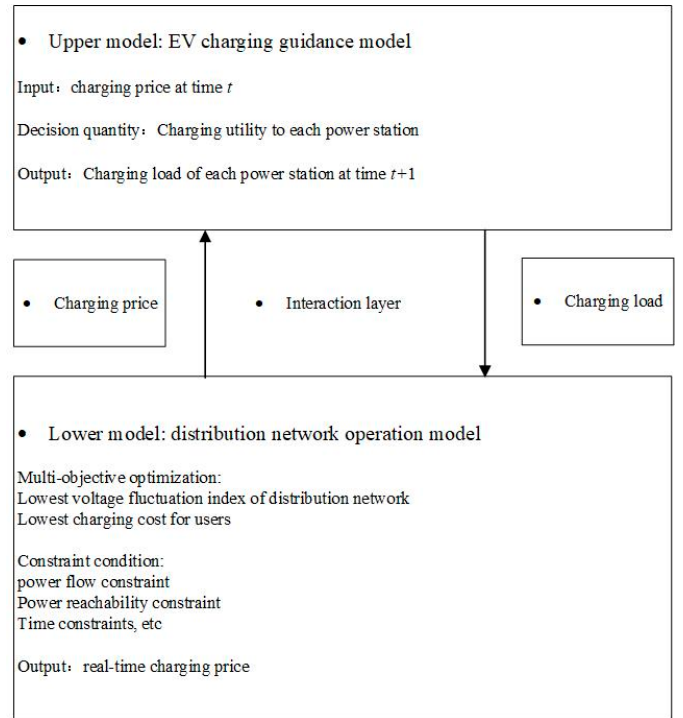
Figure 6. Bi-level collaborative optimization strategy model.